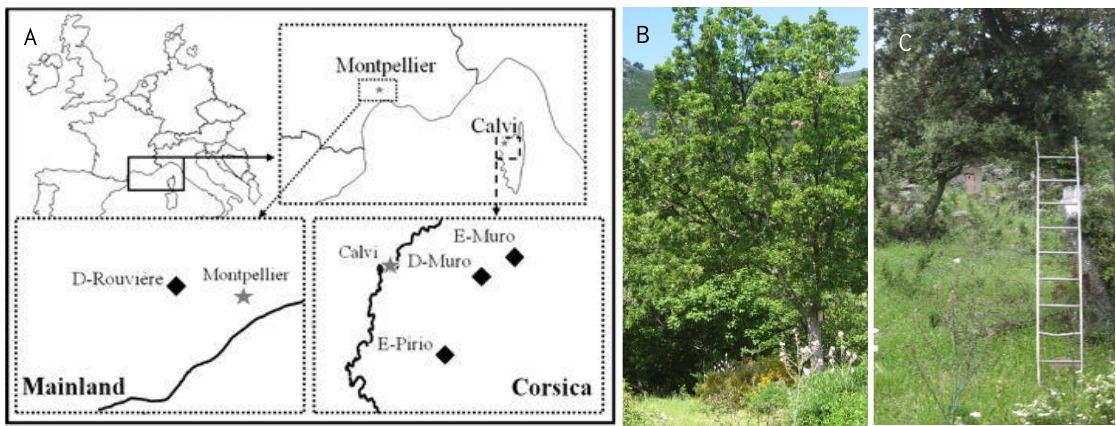
Figure 1 : A/ Location of the four focal populations of blue tits. The three Corsican sites (E-Pirio, D-Muro and E-Muro) are located ∼ 440km away from the mainland site (D-Rouviere). E-Muro is located ∼ 6km away from D-Muro and ∼ 30km from E-Pirio. Two sites are in a deciduous oak Quercus pubescens forest (D- Rouviere and D-Muro), and two in an evergreen oak Quercus ilex forest (E-Pirio and E-Muro). B/ A downy oak with a nest box in D-Muro, and C/ a holm oak with a nest box in E-Muro.